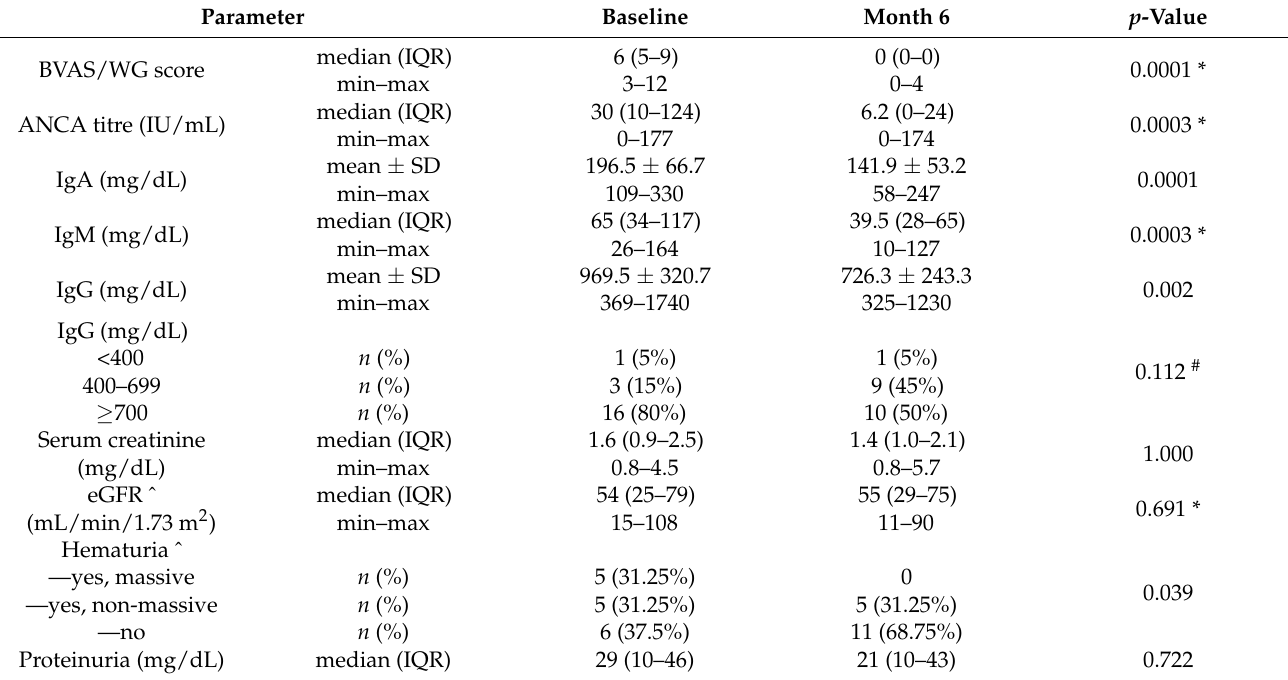
Table 3. Comparison of patients’ status at baseline and 6 months after RTX.